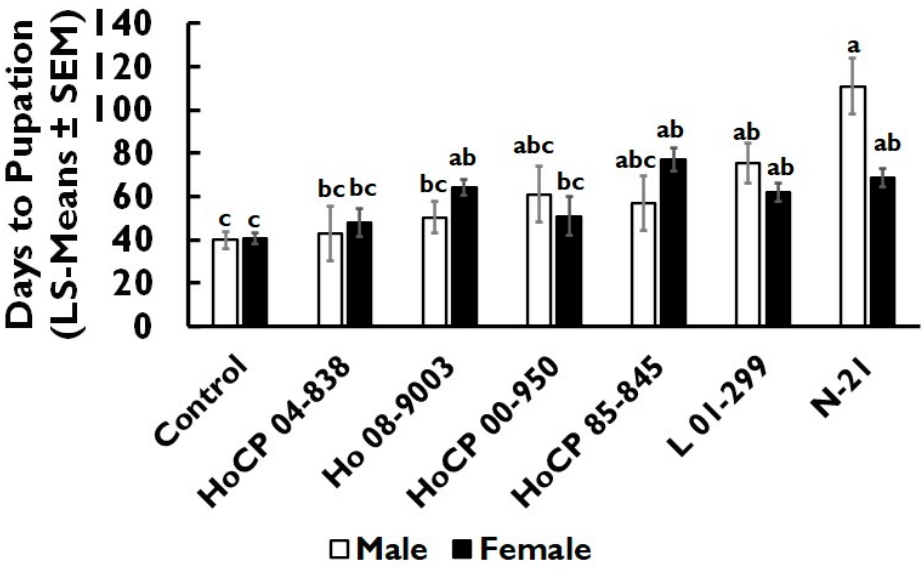
Figure 4. Eoreuma loftini days to pupation as influenced by the cultivar × sex interaction in the diet incorporation assay. Bars that share a letter are not significantly different (Tukey–Kramer HSD, α =